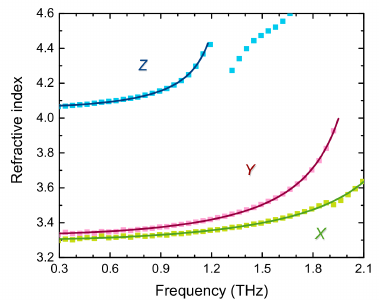
Figure 3. Measured refractive index (square symbols) of KTA crystal for THz-wave polarized in the direction of di ff erent optical axes (indicated by letters). Solid lines represent the fitting results in the form of the Sellmeier